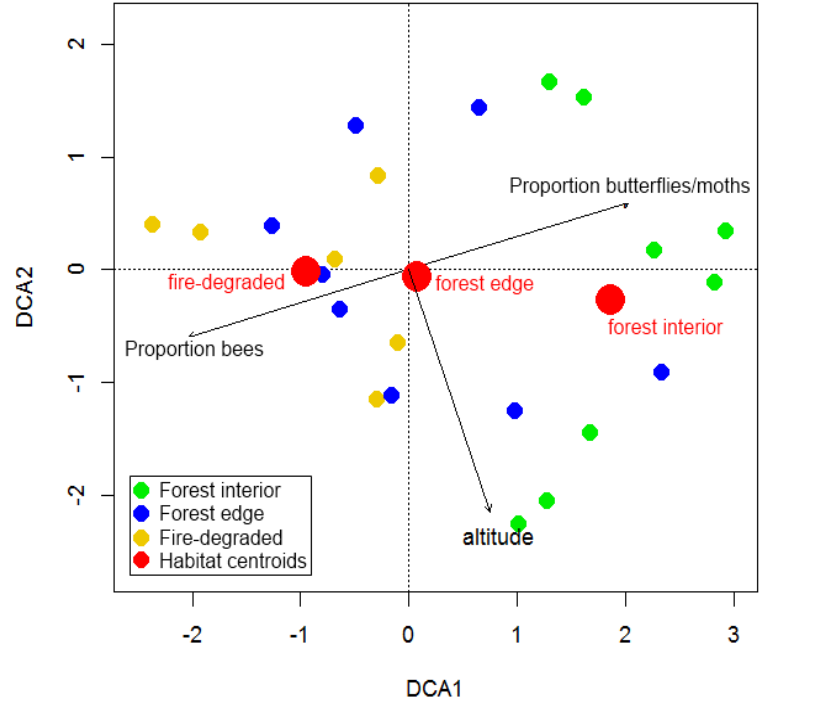
Figure 3. Result of a detrended correspondence analysis testing for species turn-over in pollinator communities of two pollinator guilds (bees, butterflies/moths) along habitat gradients comprising forest interior, forest edge and fire-degraded habitats in the Bolivian Andes. Effects of habitat type, altitude and of the proportion of pollinator guilds on community composition are indicated by the respective centroids or vectors; all effects shown were significant ( p < 0.05 in a permutation